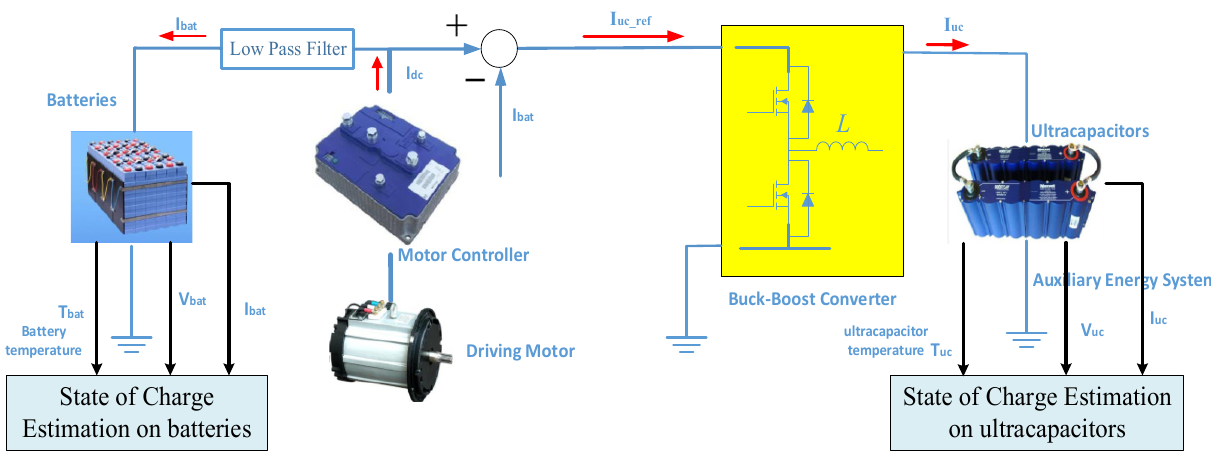
Figure 3. Current allocation scheme for ultrapacitors and batteries in regenerative braking